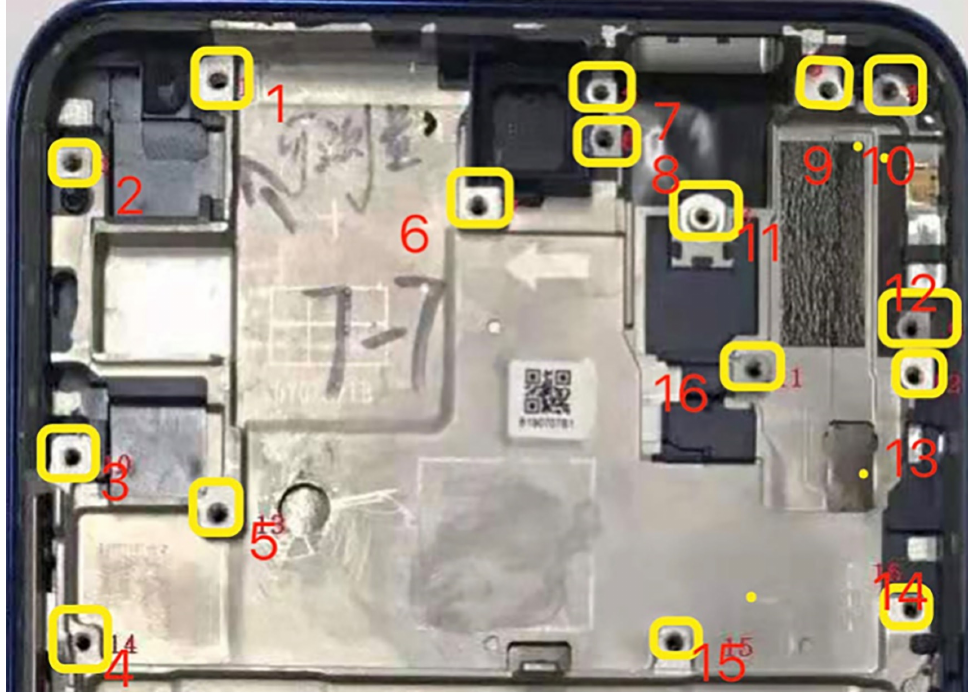
Figure 2. Label of carving position on the mobile phone